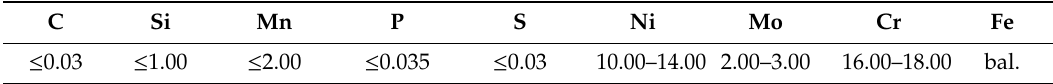
Table 1. The chemical composition of the studied steel